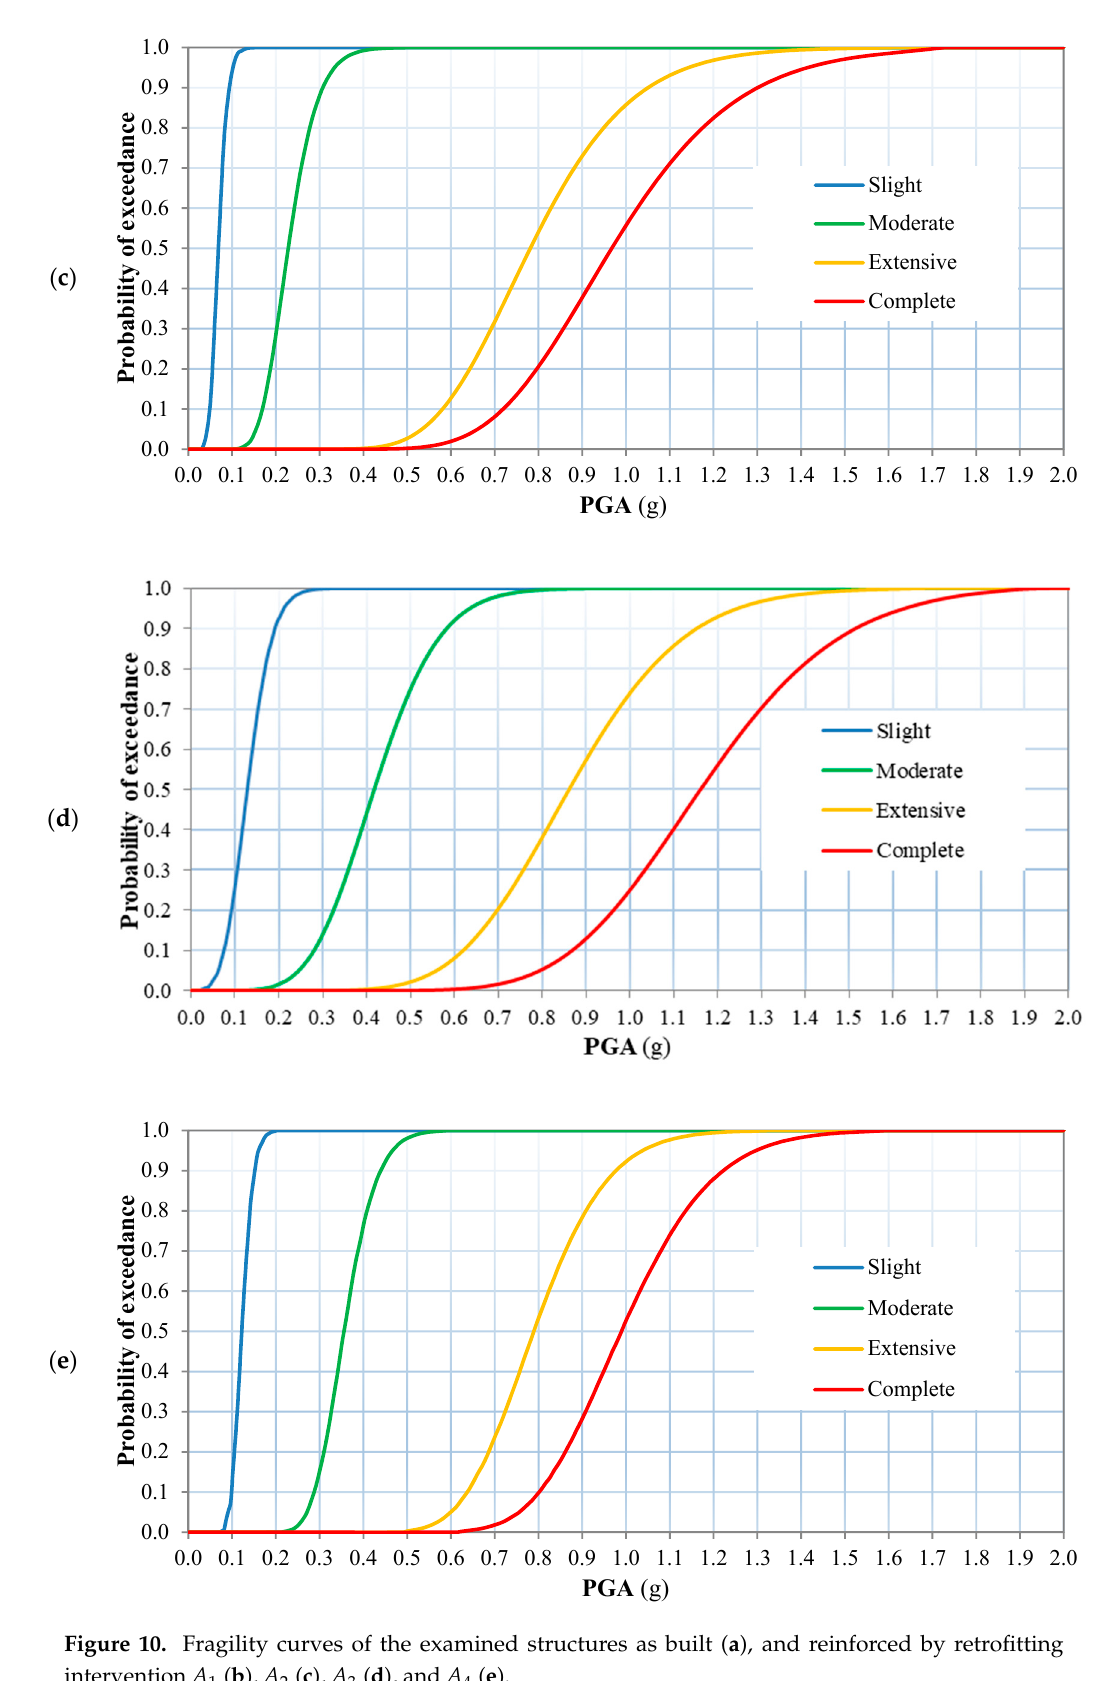
Figure 10. Fragility curves of the examined structures as built ( a ), and reinforced by retrofitting intervention A 1 ( b ), A 2 ( c ), A 3 ( d ), and A 4 ( e